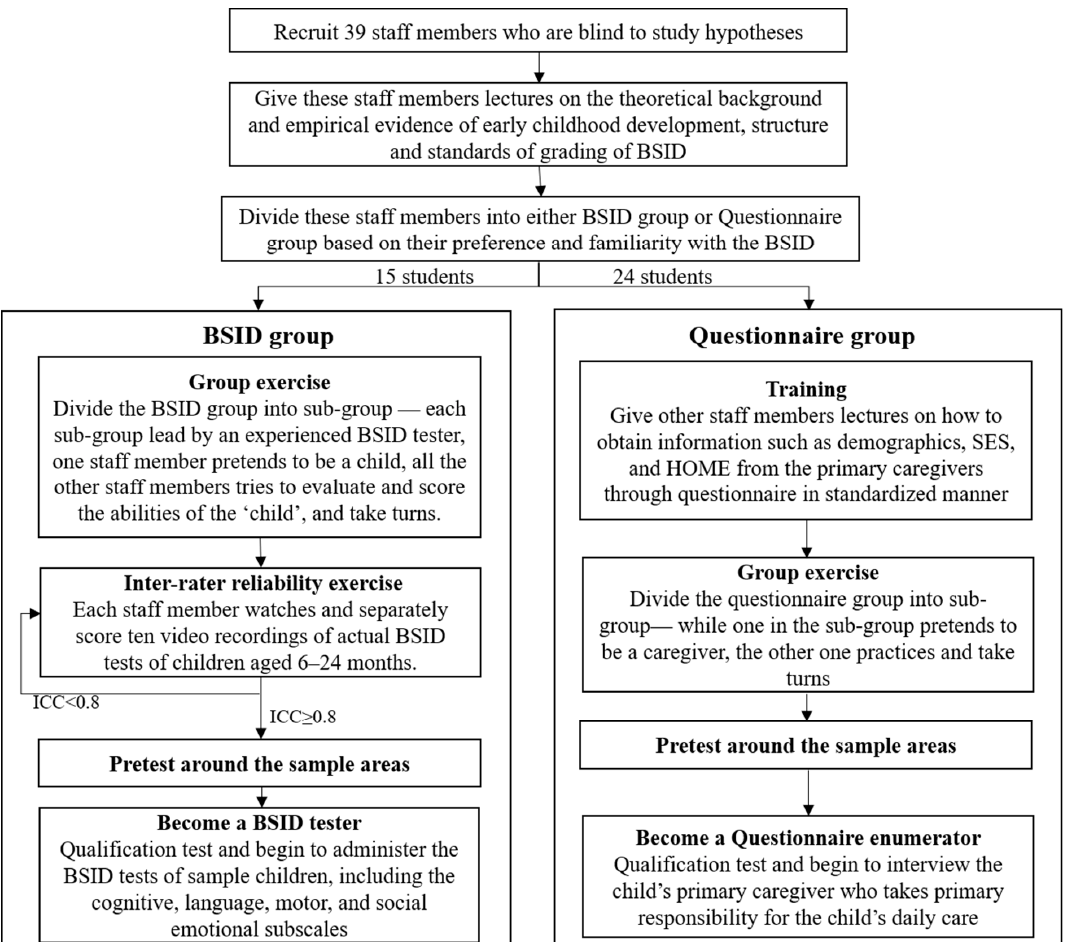
Figure A1. Flowchart of training staff members.